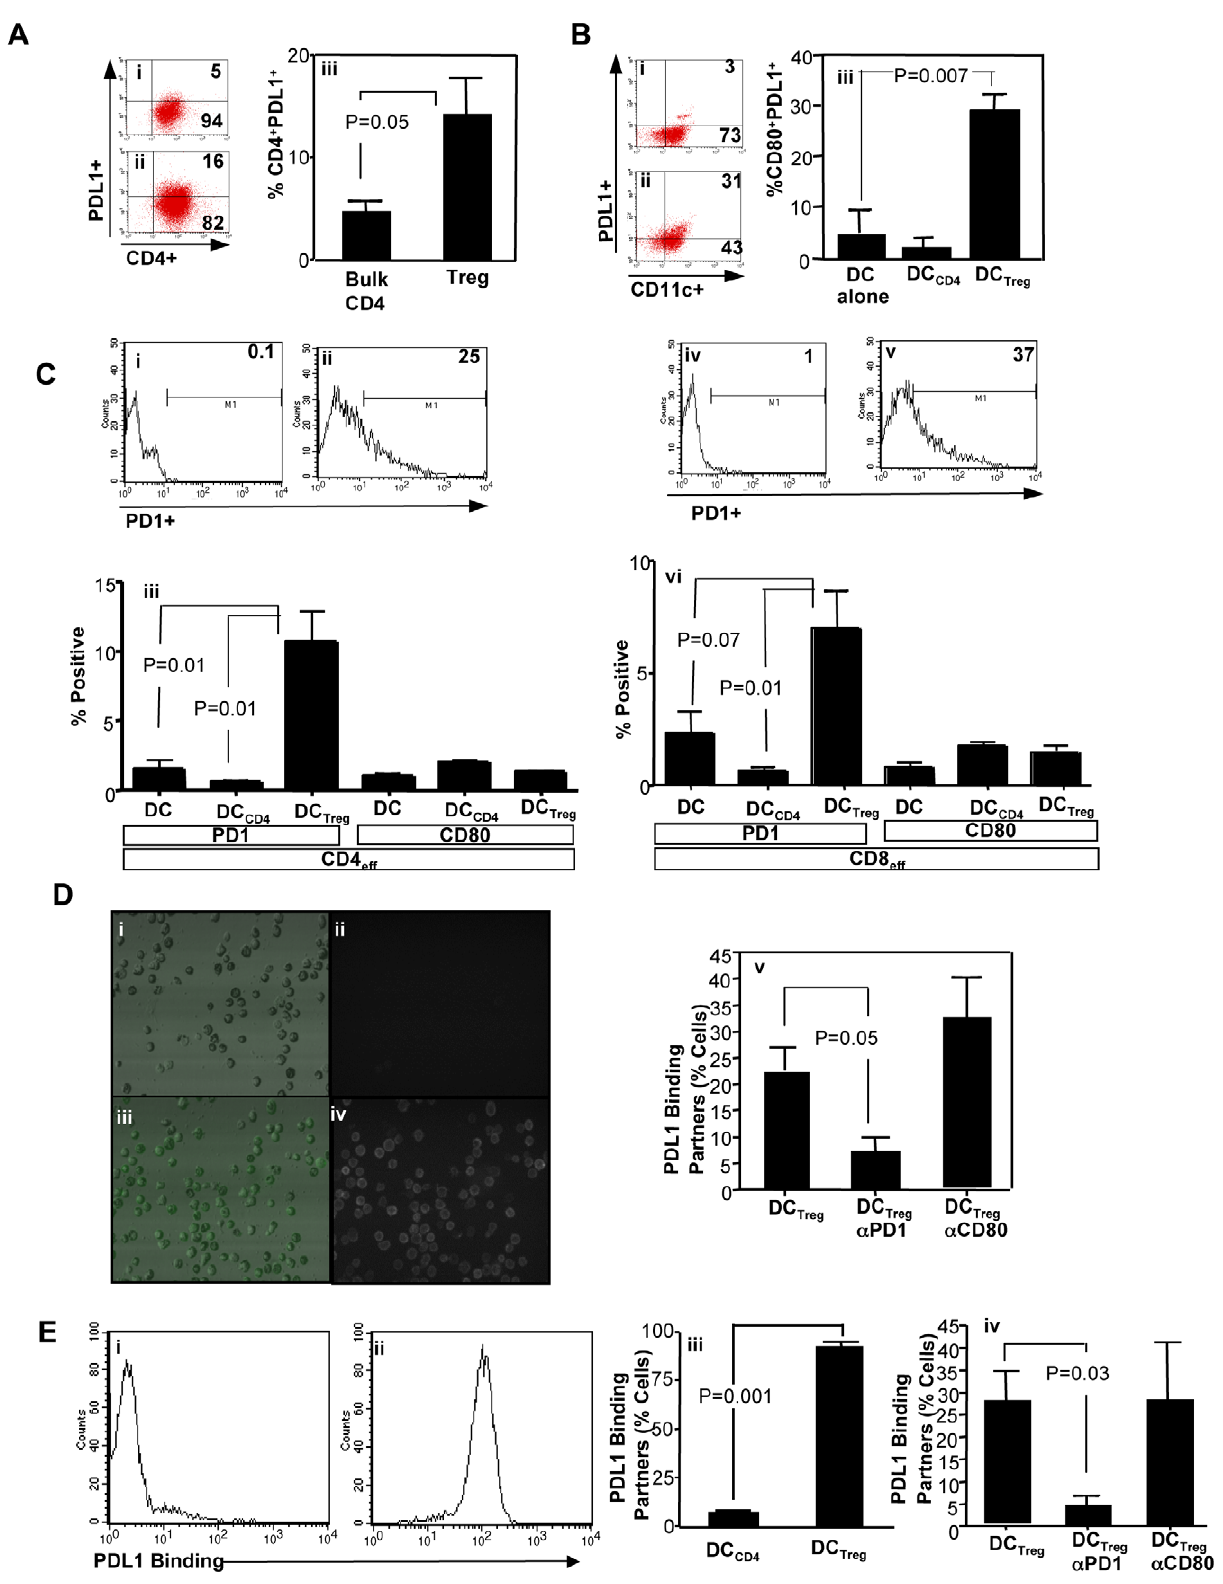
Figure 1. Tregs express PD-L1 and modulate the PD-1 pathway. (A) Representative flow data for control CD4 cell and Treg expression of PDL1 ((i) and (ii), respectively). (iii) represents summation of results (mean 6 SEM of n = 4 experiments). (B) Control CD4 cells and Tregs were cocultured with pooled allogeneic DC for 24 h (Treg to DC ratio, 1:1) to generate ‘‘DC CD4 ’’ and ‘‘DC Treg ’’ populations, respectively. Control CD4 cells and Tregs were then removed and resultant conditioned DC were evaluated for coexpression of CD80 and PD-L1.